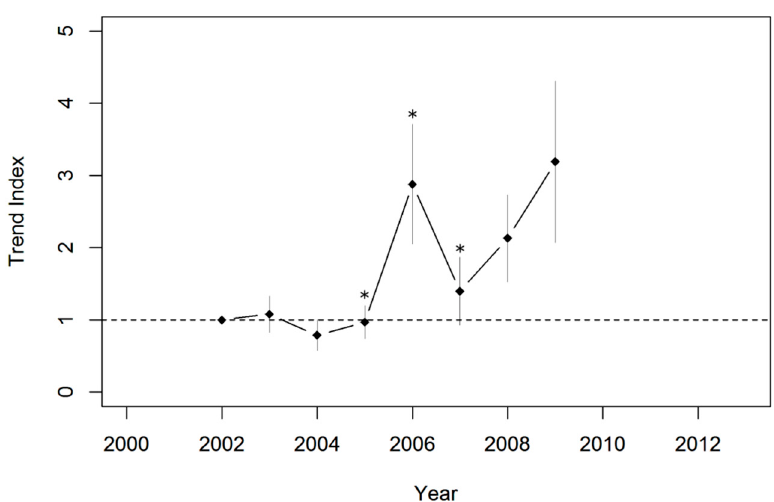
Figure 3. Puma population trends based on the imputed trend indices estimated by the most parsimonious time-e ff ect model (stepwise time e ff ect model; Supplementary Material Table S1) for autumn (2002–2009). Time points incorporated in the model as significant change points on population trend are marked with asterisks (*). Vertical bars represent the SE of trend indices. The horizontal dashed line represents the index value for the base year (2002).